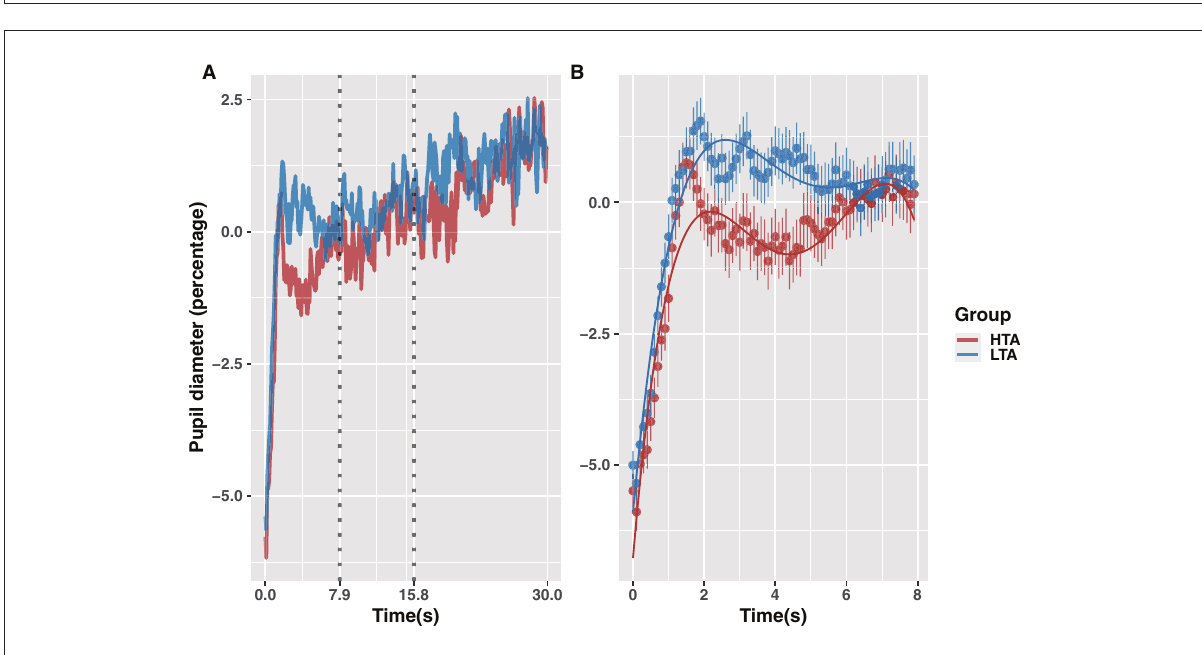
FIGURE5 Rate of change in pupil diameter in the HTA and LTA groups (A) . GCA model fits for pupil-diameter data of the HTA and LTA groups (0–7.9s) (B)